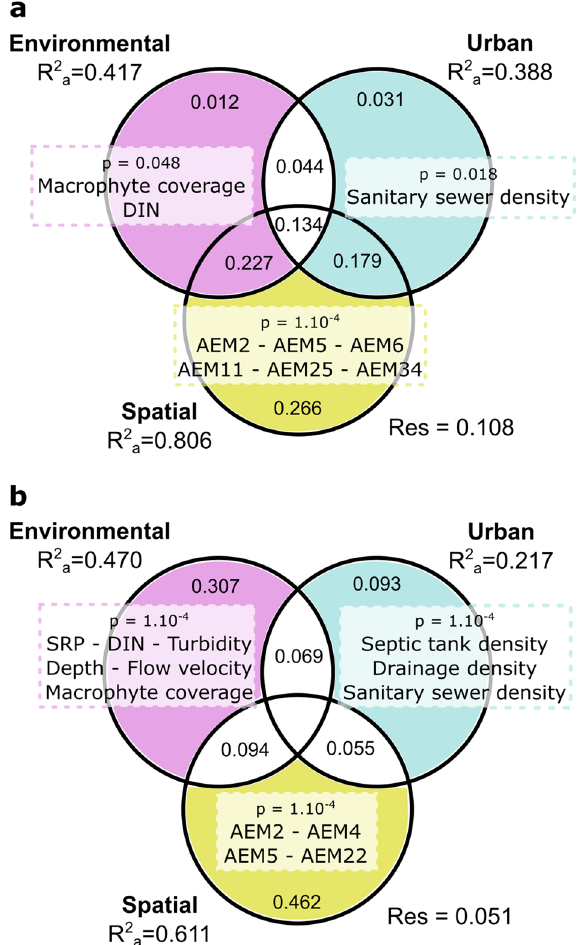
Figure 4. Drivers of E. coli population structure. Venn diagrams of the results of variation partitioning analysis of response variables explained by environmental, urban infrastructure and spatial contributing factors: ( a ) abundance of E. coli ; ( b ) phylogenetic composition. The contribution of each predictor set is represented by R 2 adjusted values and p -values, when available; values < 0 are not shown. Significant parameters derived from each pRDA from each predictor matrix are listed in each diagram ( p < 0.05); color-shaded areas represent the evaluated fraction for each main matrix. DIN, dissolved inorganic nitrogen; SRP, soluble reactive phosphorus; AEM, asymmetric eigenvector map; Res, residuals. Data analysis performed in R software 73 . Graphical edition in Inkscape V 0.92.4. Inkscape Project (2020). https:// inksc ape.